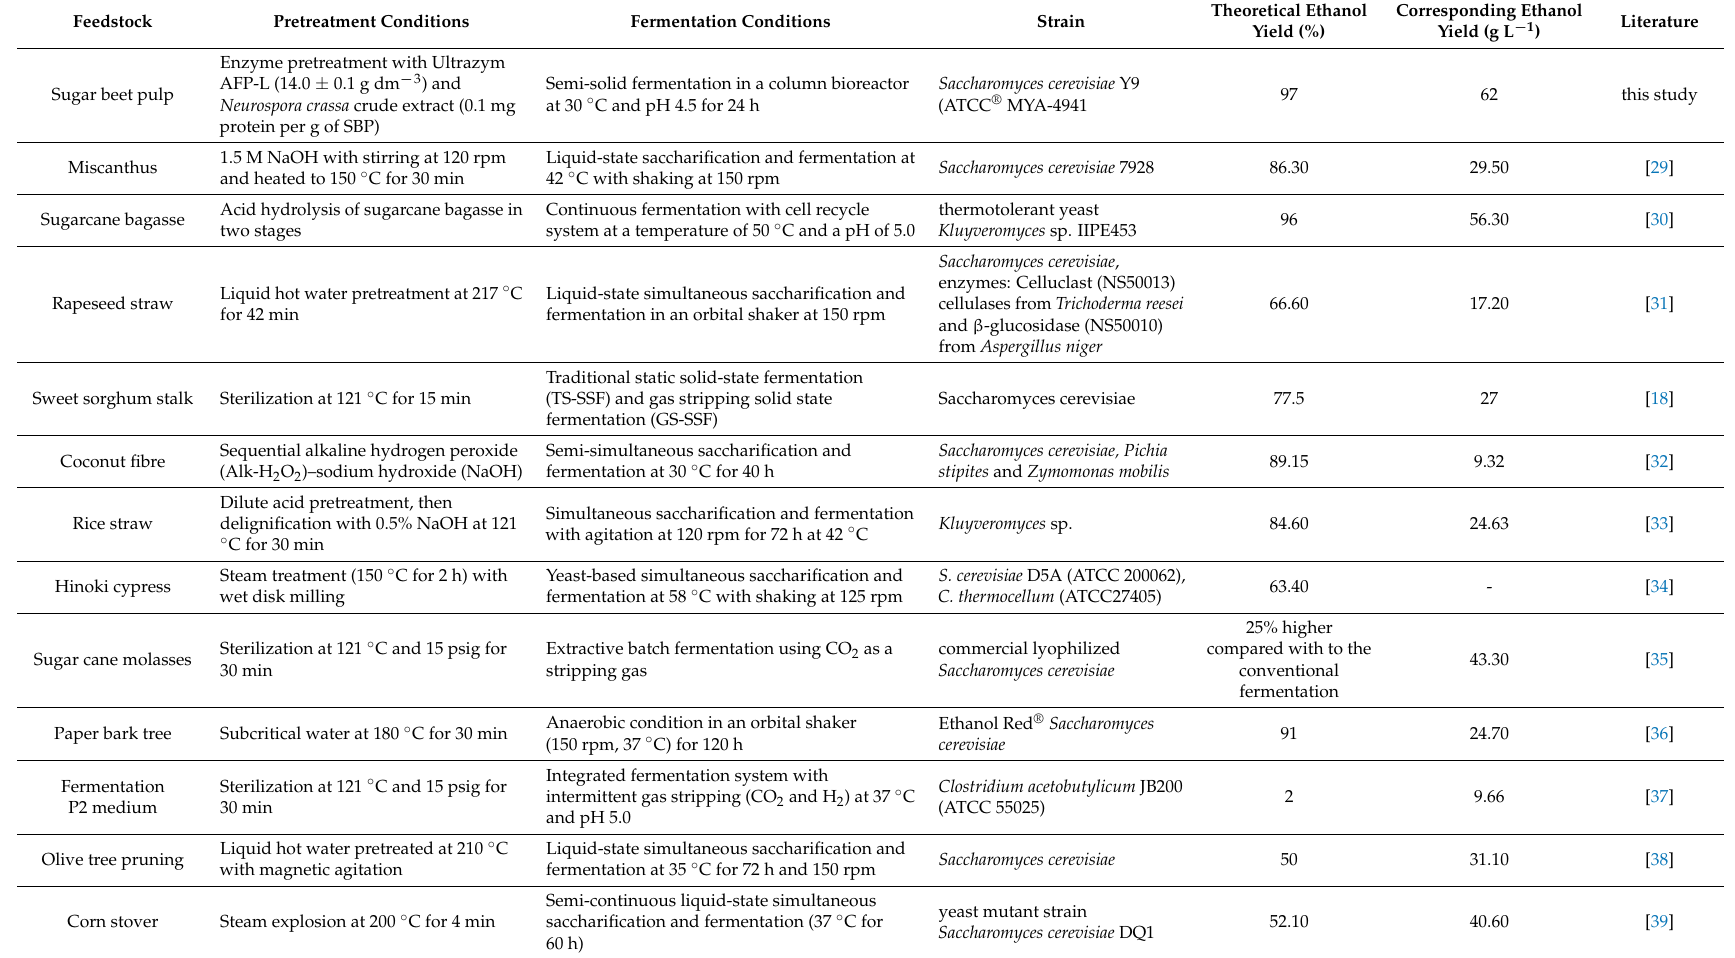
Table 4. Overview of literature reports on lignocellulosic biomass fermentation for bioethanol